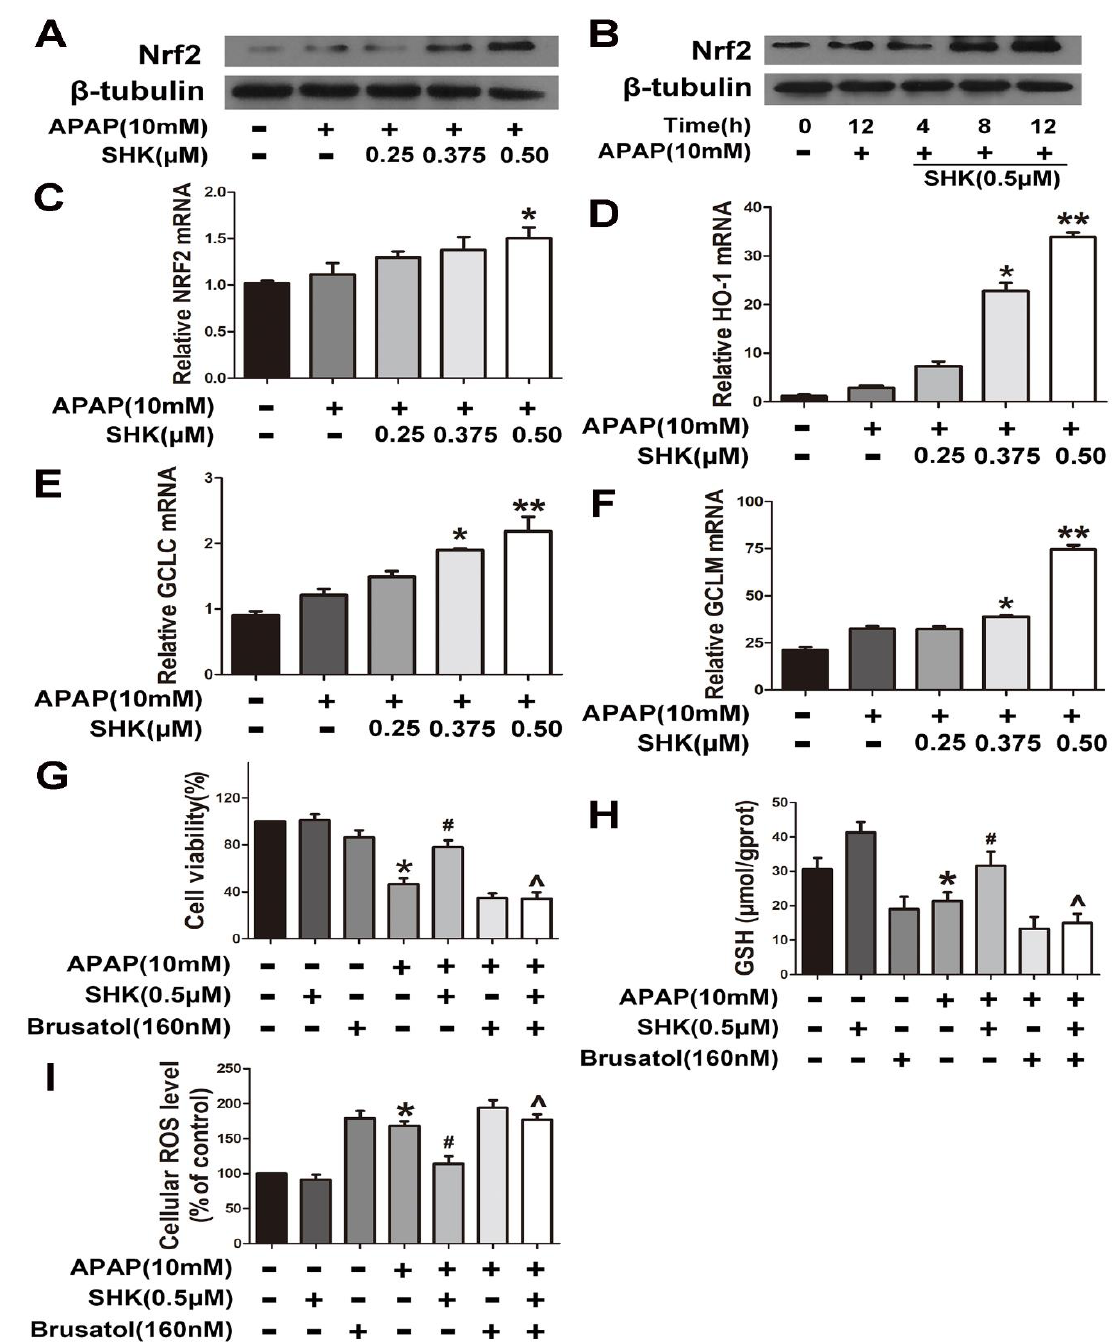
Figure 4. Effects of SHK are dependent upon Nrf2 in L-02 cells. ( A , B ) L-02 cells were treated with SHK for the indicated durations, and then the protein levels were examined by western blot analysis. ( C – F ) L-02 cells were treated with increasing concentrations of SHK for 1 h followed by 4-h APAP treatment, and then the mRNA expression of Nrf2, HO-1 , GCLc and GCLm was detected by real-time polymerase chain reaction (PCR). ( G – I ) Cells were pretreated with brusatol (160 nM) for 2 h, followed by treatment with SHK for 1 h, and then the cells were exposed to APAP for 24 h. Cell viability, GSH and ROS level was assessed. All of the data shown represent the average from three independent experiments. * p < 0.05 versus the control group; # p < 0.05 versus the APAP group; ˆ p < 0.05 versus the SHK plus APAP group.